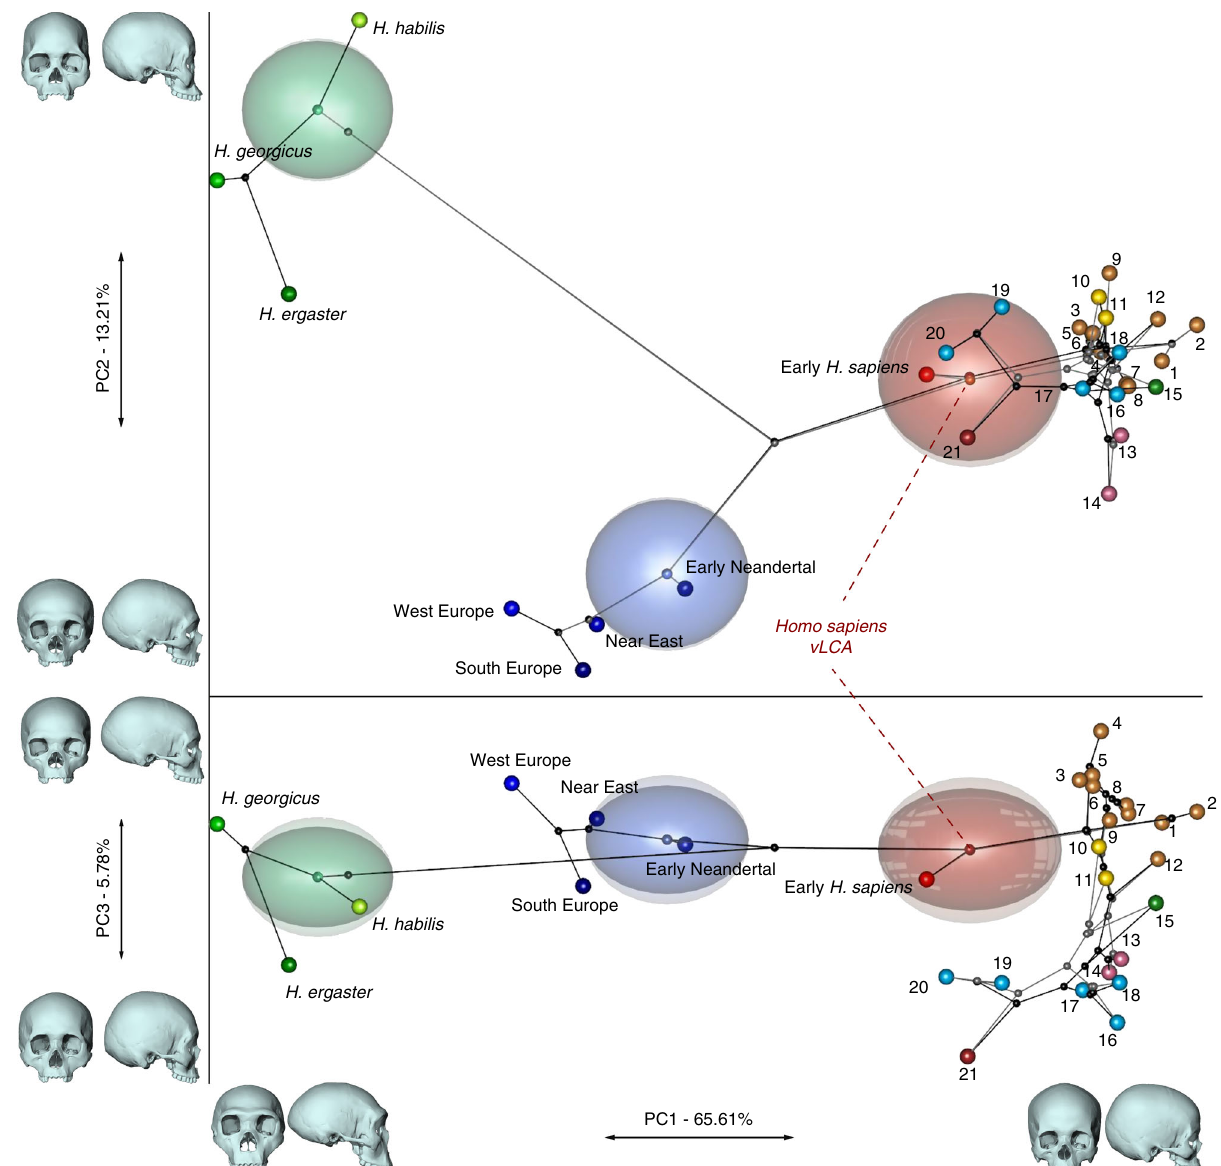
Fig. 2 Projection of phylogenetic hypotheses 1 (black) and 2 (grey) into the morphospace. The associated shape deformations are displayed next to each PC. Each node represents estimated ancestors ’ shapes along with 95% con fi dence envelopes. Both trees are similar on PC1 and 2, while PC3 highlights differences between both hypotheses within the modern human clade. Modern human populations as follow: 1 to 9 Sub-Saharan Africa; 10 – 11 Oceania,